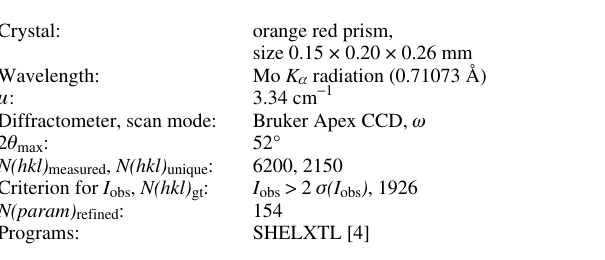
Table 1. Data collection and handling.